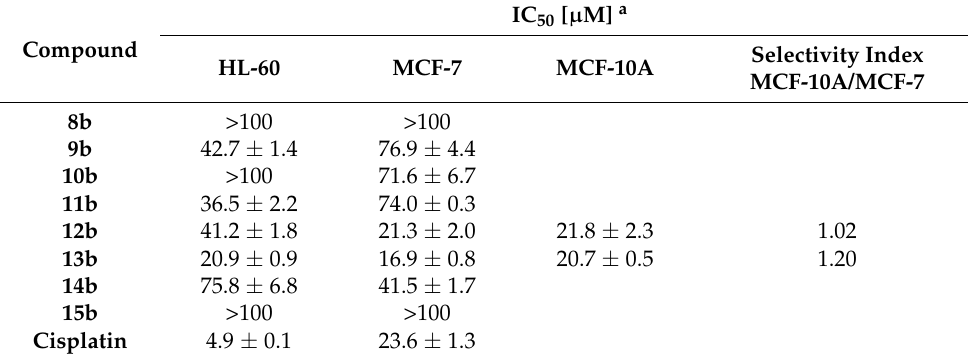
Table 2. Cytotoxic activity of tetrachloroaurate(III) salts 8b – 15b. IC 50 [ µ M] a Compound Selectivity HL-60 MCF-7 MCF-10A